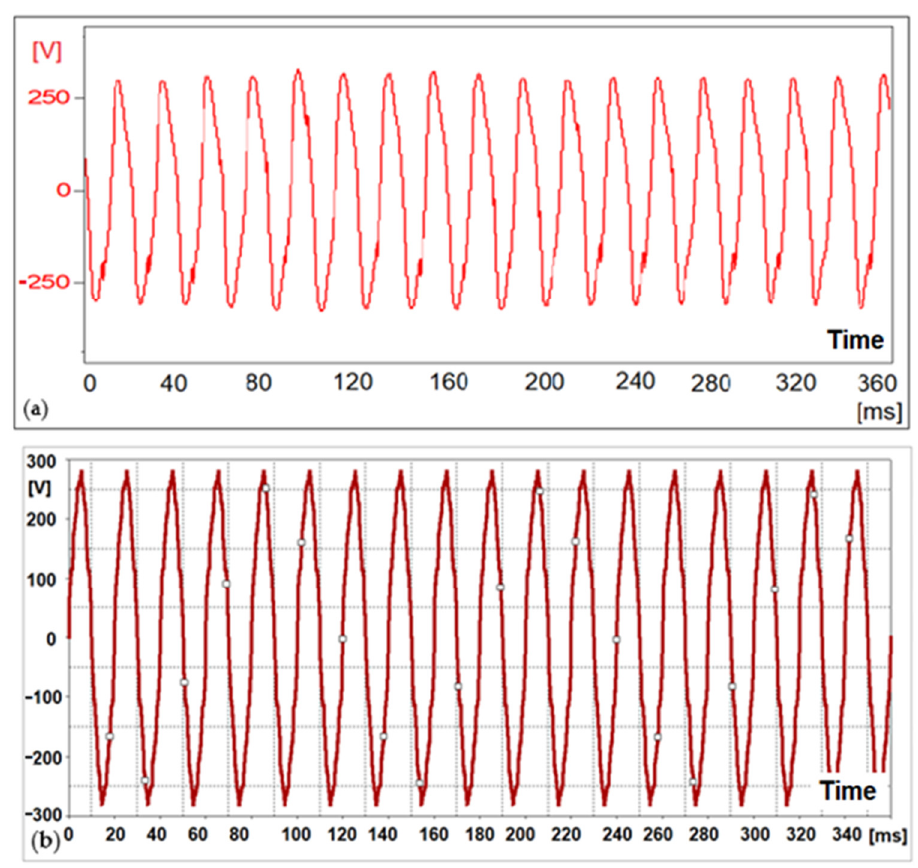
Figure 17. Electric arc voltage oscillograms recorded in real conditions ( a ) and determined using the proposed model ( b )—after melting the charge [31].